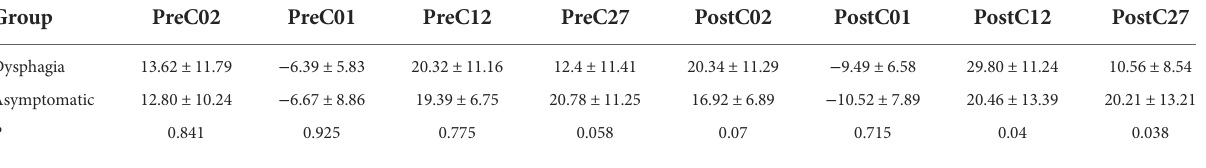
TABLE 2 Comparison of cervical alignment between dysphagia and asymptomatic groups (°).